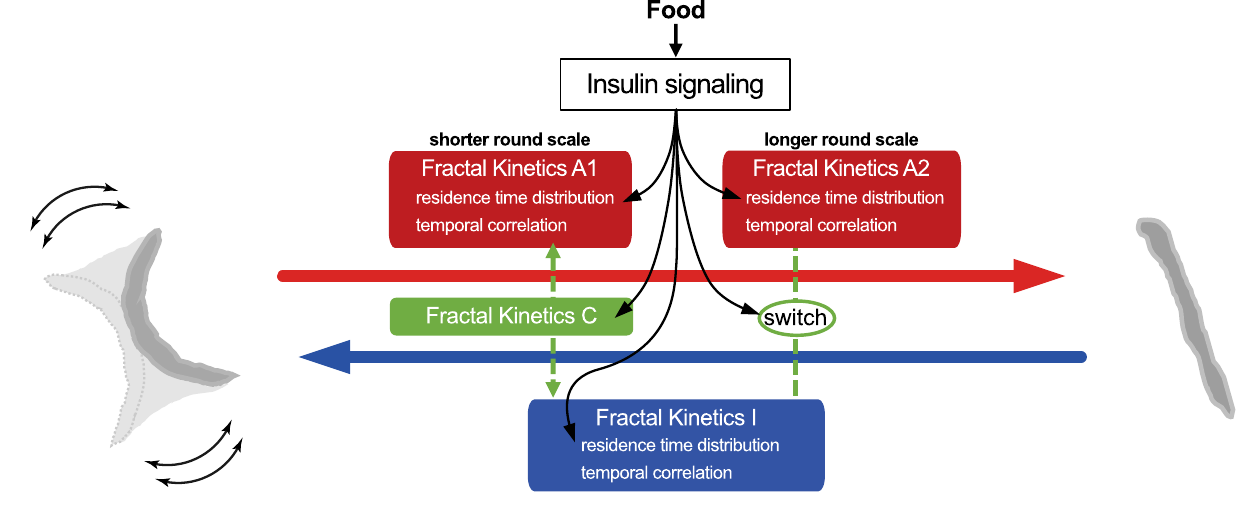
Figure 4. Two-state behavioral transition model. State transition from the active to inactive state is driven by Fractal Kinetics A1 at shorter round scale (which is affected by Fractal Kinetics C) and is driven by fractal Kinetics A2 at longer round scale (which is affected by Fractal Kinetics I). State transition from the inactive to active state is driven by Fractal Kinetics I, which is affected by Fractal Kinetics C at the shorter round scale, and is affected by Fractal Kinetics A2 at the longer round scale. Insulin signaling targets Fractal Kinetics A1, A2, C, and the lateral linking